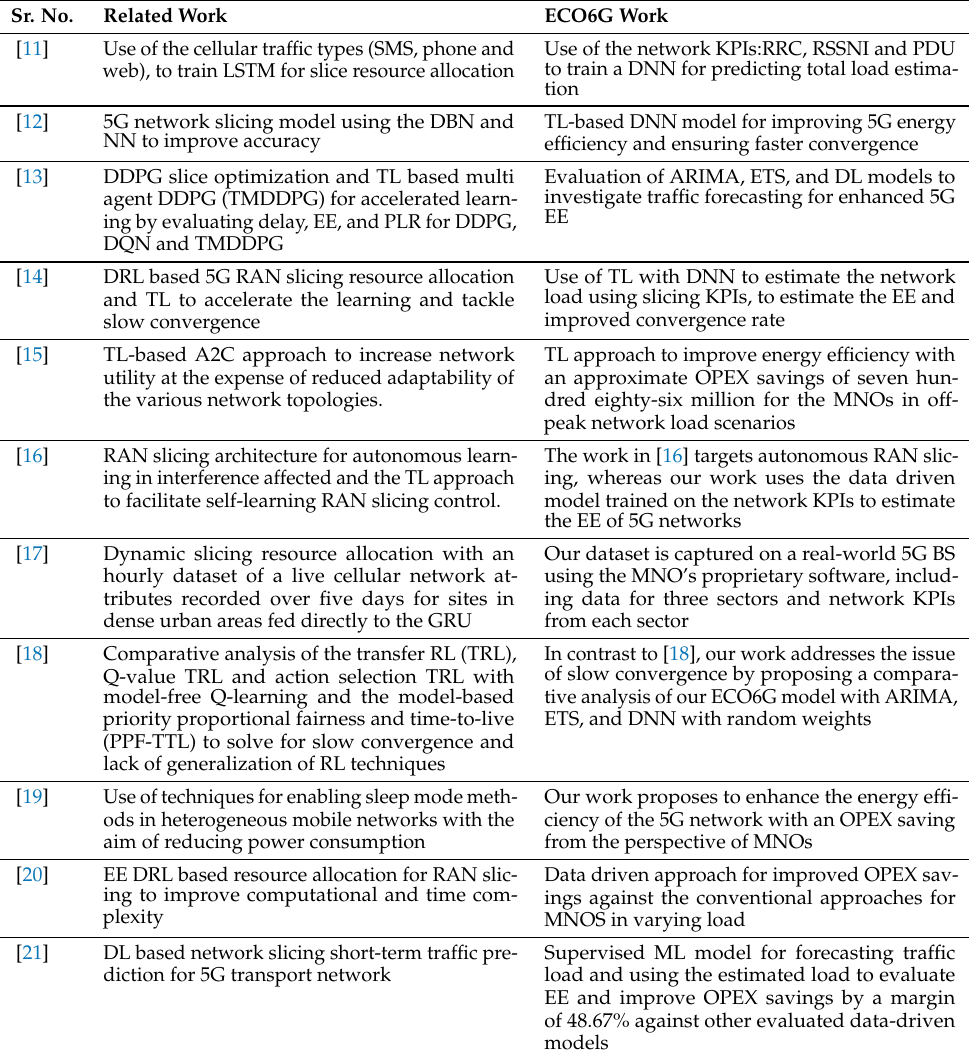
Table 1. Comparison of ECO6G against state-of-the-art methodologies. Sr.